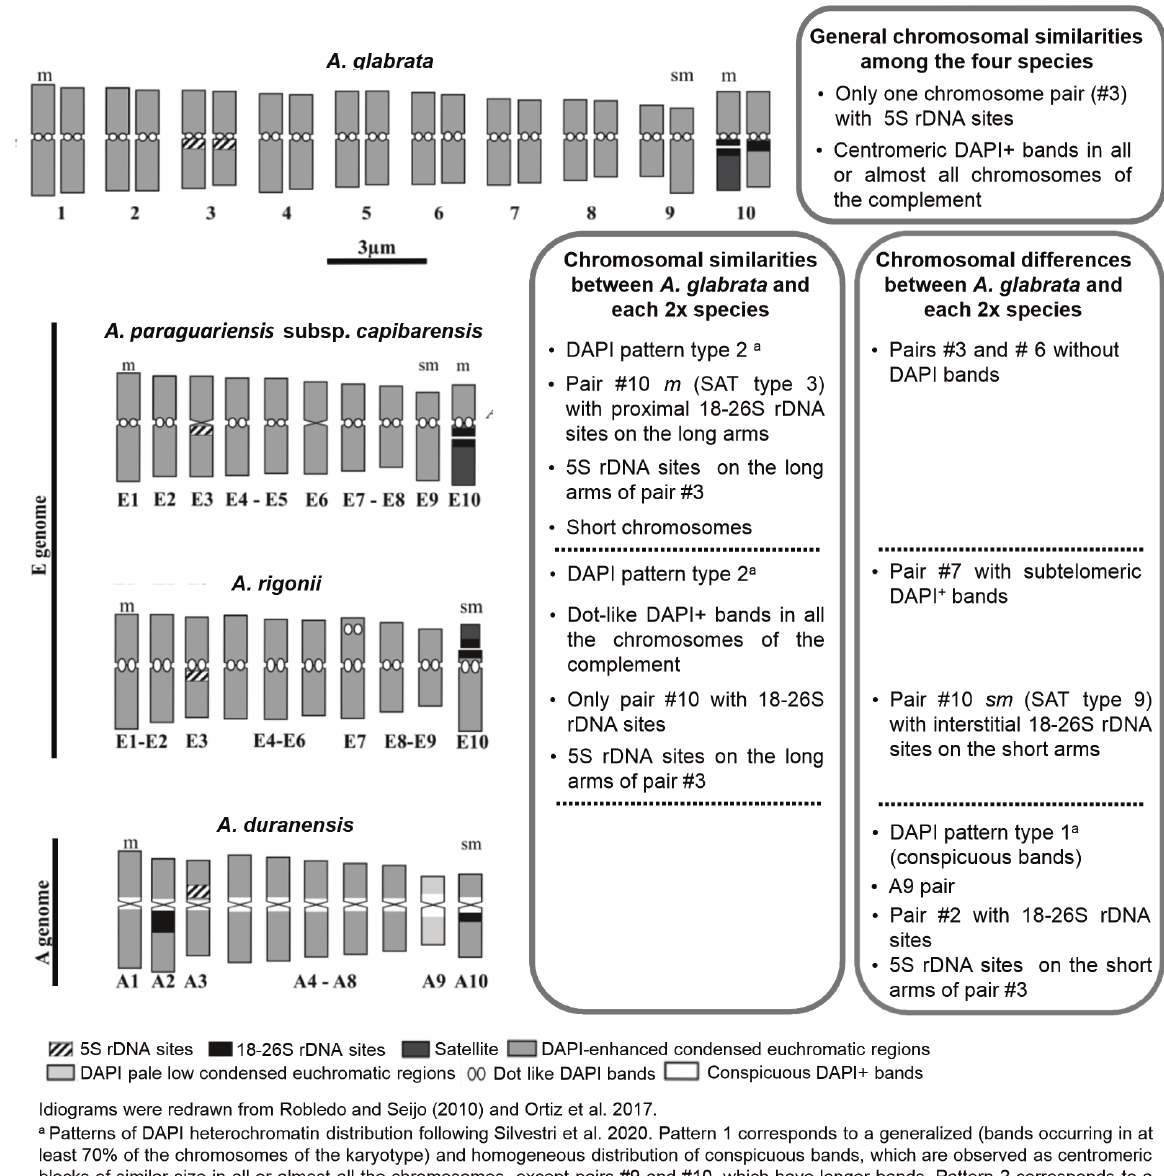
Figure 4. Scheme showing the idiograms and the main chromosomal similarities and differences between A. glabrata and the three diploid species tested in the double GISH